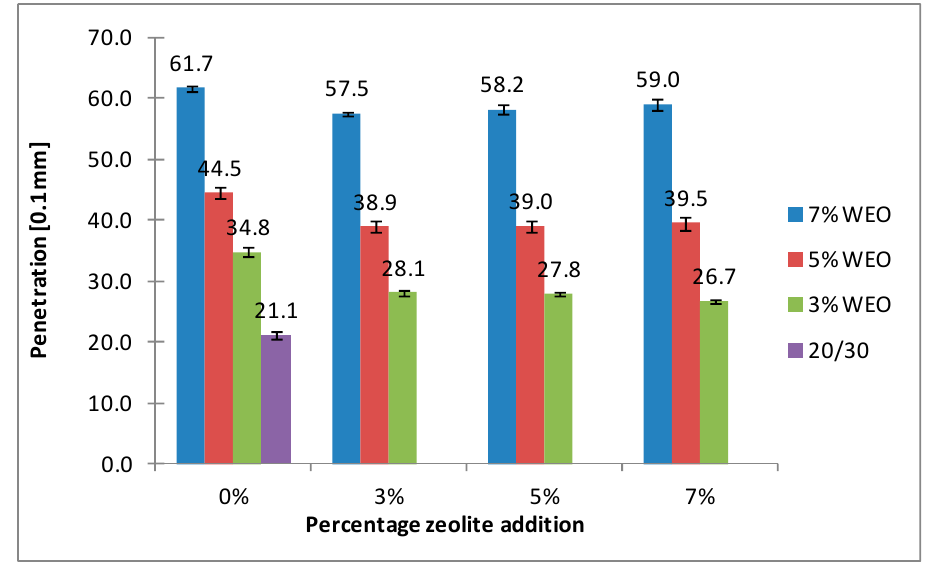
Figure 12. The results of penetration tests for the 20/30 asphalt with the addition of WEO and Na-P1 zeolite measured at 25 °C.